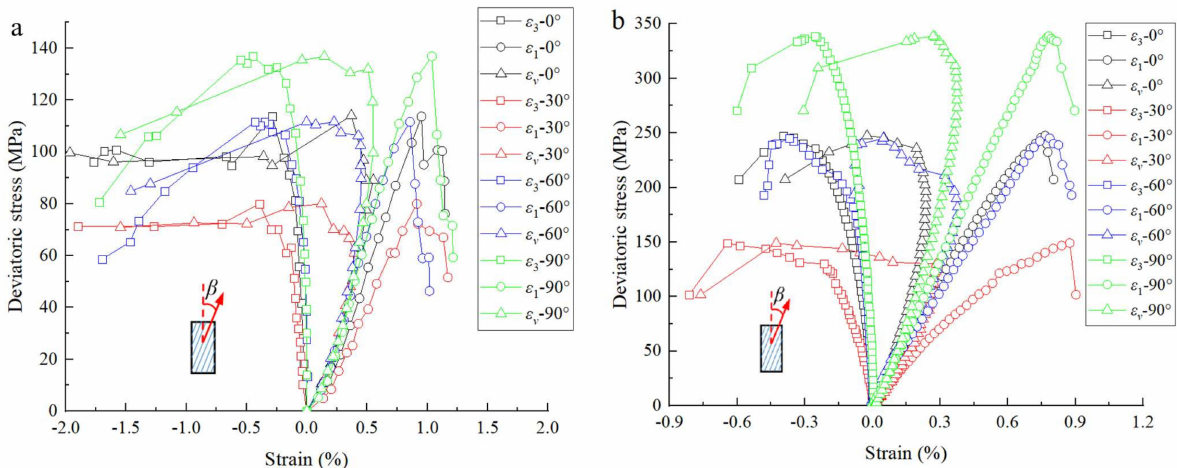
Figure 3. Complete stress − strain curves of the dry samples of ( a ) lamellar shale and ( b ) bedding shale